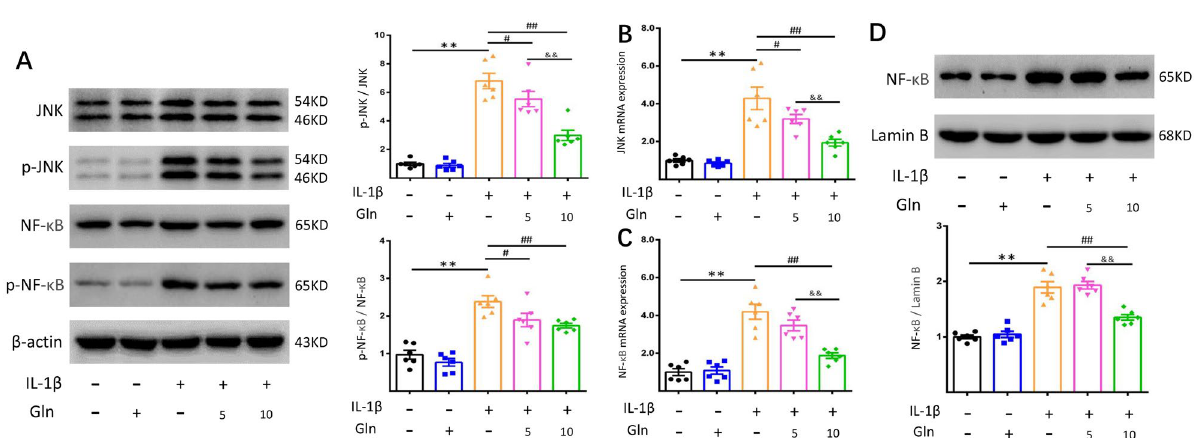
Figure 4. Gln suppressed IL-1β-induced JNK and NF-κB expression in chondrocytes, and the high concentration Gln exhibited a greater effect. ( A ) Protein expression levels of JNK, p-JNK, NF-κB, and p-NF-κB were examined by western blotting with β-actin as the internal standard. ( B , C ) JNK and NF-κB mRNA expression was measured using qRT–PCR. ( D ) The nucleoprotein expression of NF-κB was checked by western blot with Lamin B as the internal standard. All data are presented as the M ± SEM (n = 6 in each group). *p < 0.05 vs. IL-1β(−) and Gln(−) group, **p < 0.01 vs. IL-1β(−) and Gln(−) group; # p < 0.05 vs. IL-1β(+) and Gln(−) group, ## p < 0.01 vs. IL-1β(+) and Gln(−) group; & p < 0.05 vs. IL-1β(+) and Gln(5) group, && p < 0.01 vs. IL-1β(+) and Gln(5) group by